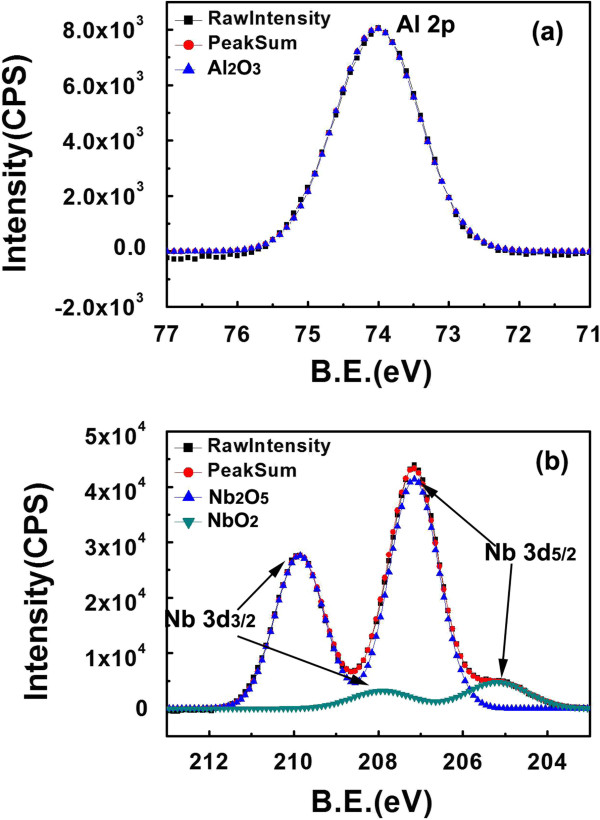
The XPS spectra of NbAlO film chemical composition. (a) The Al 2p peak shows the Al2O3 and (b) the Nb 3d3/2 and 3d5/2 peaks show the Nb2O5 and NbO2, respectively. The B.E. means binding energy in x-axis.